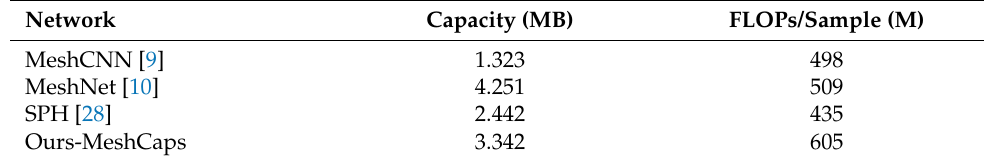
Table 3. Parameter comparison test.